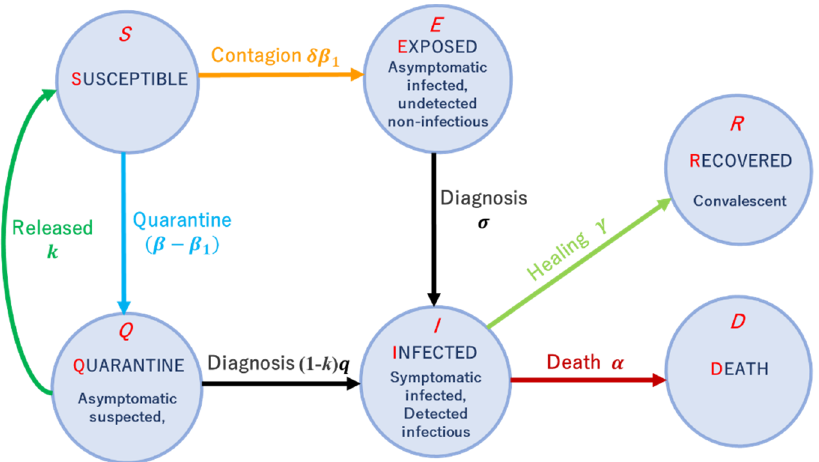
Figure 1. The SQEIR model. Graphical scheme representing the interactions among different stages of infection in the multi-regional-SQEIR model: S , susceptible (uninfected); Q , quarantine (suspected patients in contact with the infected, undetected); E , exposed (infected but did not develop clinical symptoms, undetected, non-infectious); I , infected (infected with symptoms, detected, infectious); R , recovered (recovered); D , death (dead).